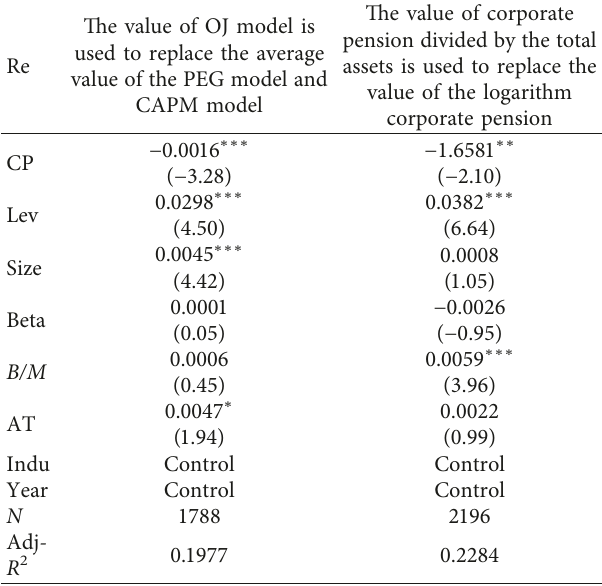
Table 8: Substitution variable regression test.